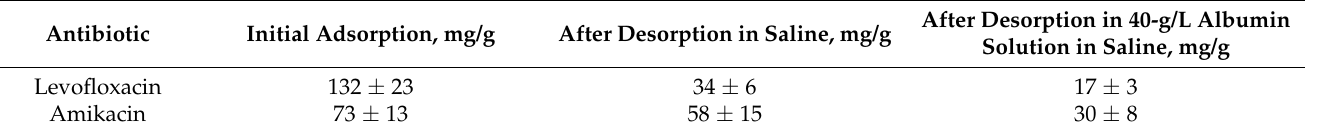
Table 2. Antibiotics surface concentration on DND surface before desorption and after cultivation in saline and in 40 g/L albumin solution in saline.